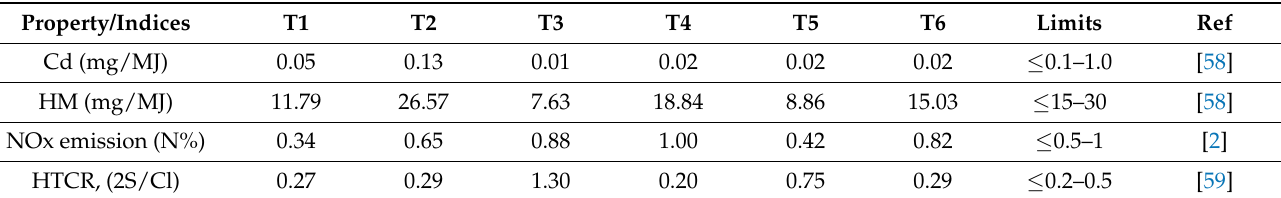
Table 3. Heavy metals and some useability indices.